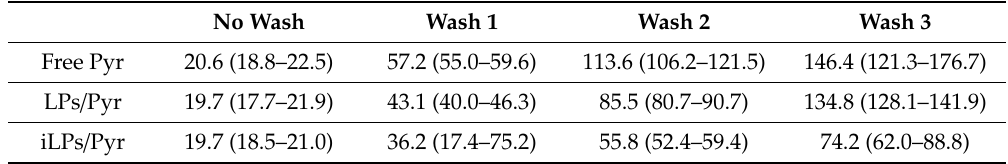
Figure 4. Pyronaridine growth inhibition assays in in vitro P. falciparum cultures. Scheme of pyronaridine-encapsulating ( A ) LP and ( B ) iLP. ( C ) Growth inhibition assays where pyronaridine was either (Unwashed) present for the whole 48 h of incubation or (Wash 1, 2, and 3) removed in 15 min-spaced washes. Table 1. Pyronaridine IC 50 values (nM) in in vitro P. falciparum cultures. 95% confidence intervals are indicated in